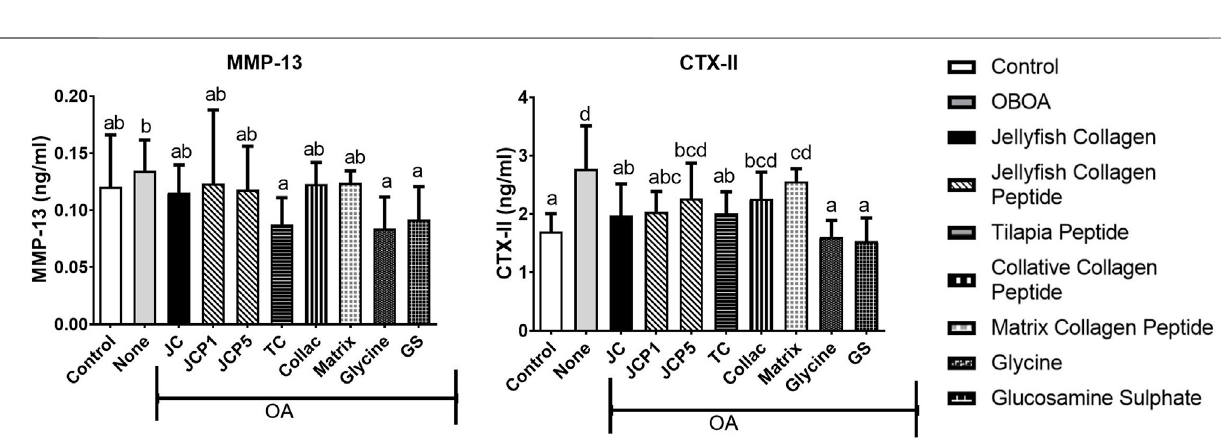
Frontiers in Bioengineering and Biotechnology |